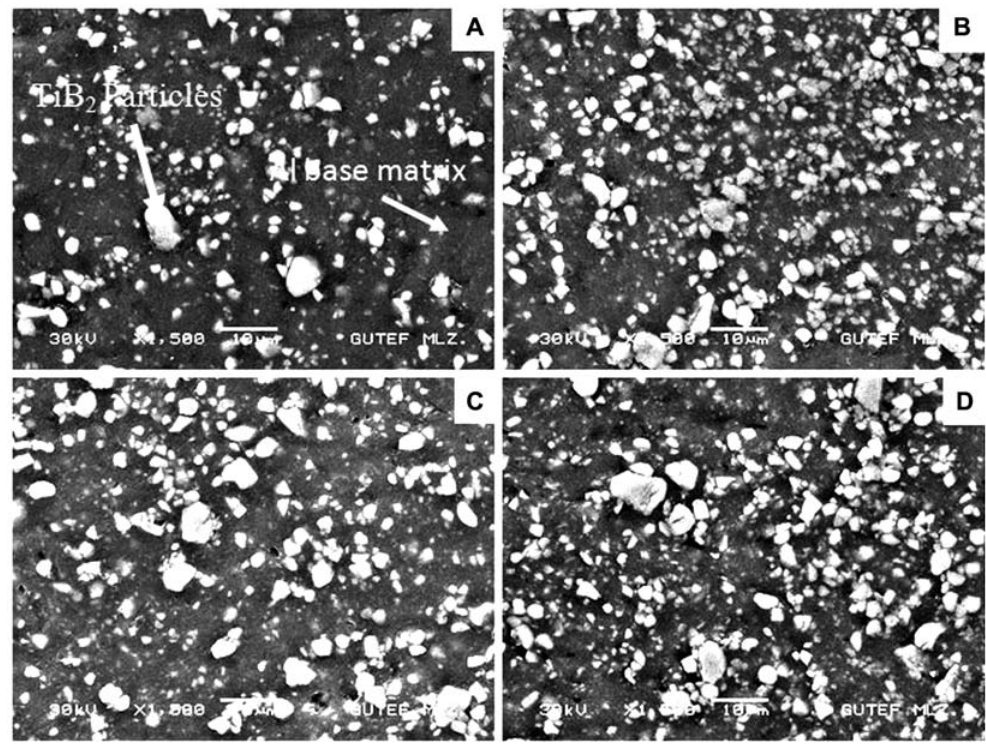
Figure 1 SEM images of Al matrix composites reinforced with (A) 5 % TiB